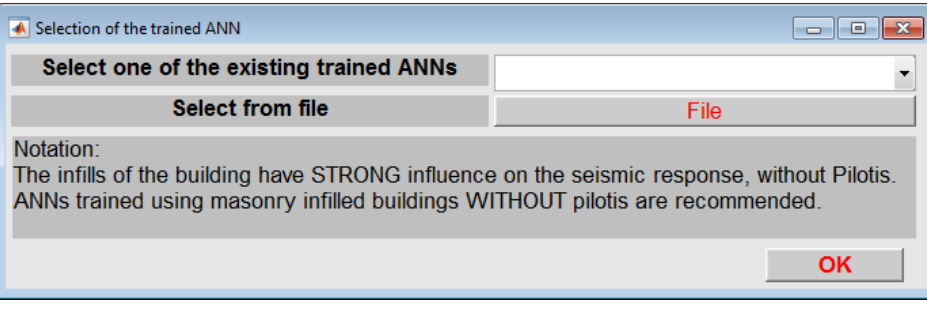
Figure 11. The file selector activated for the selection of the trained MFPNN.